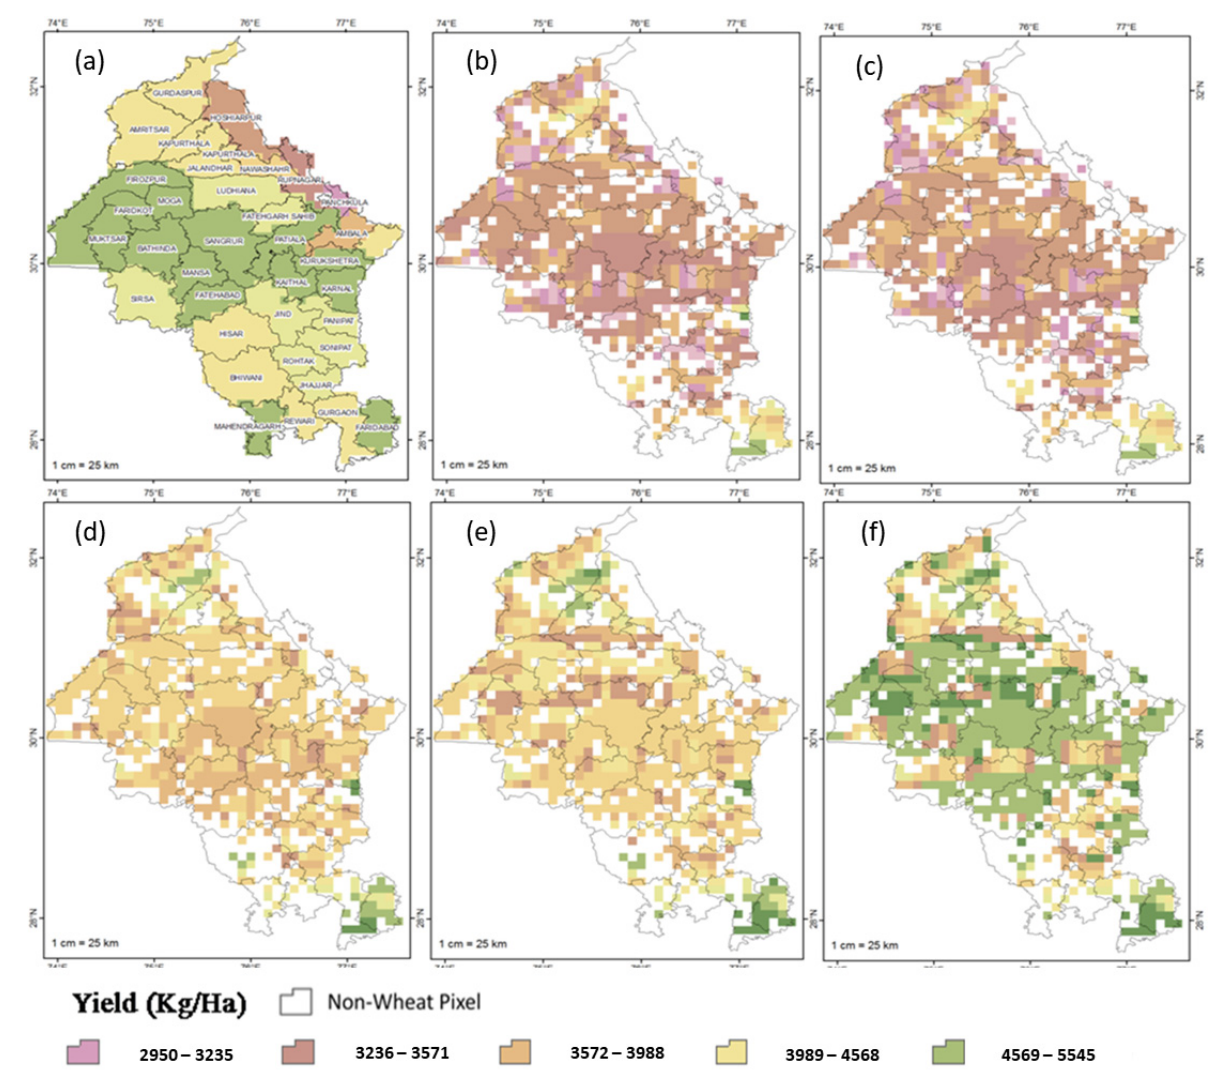
Figure 6. Spatial yield maps. ( a ) Reported district-wise yield. ( b ) F1 simulated yield. ( c ) F2 simulated yield. ( d ) F3 simulated yield. ( e ) F4 simulated yield. ( f ) F5 simulated yield.